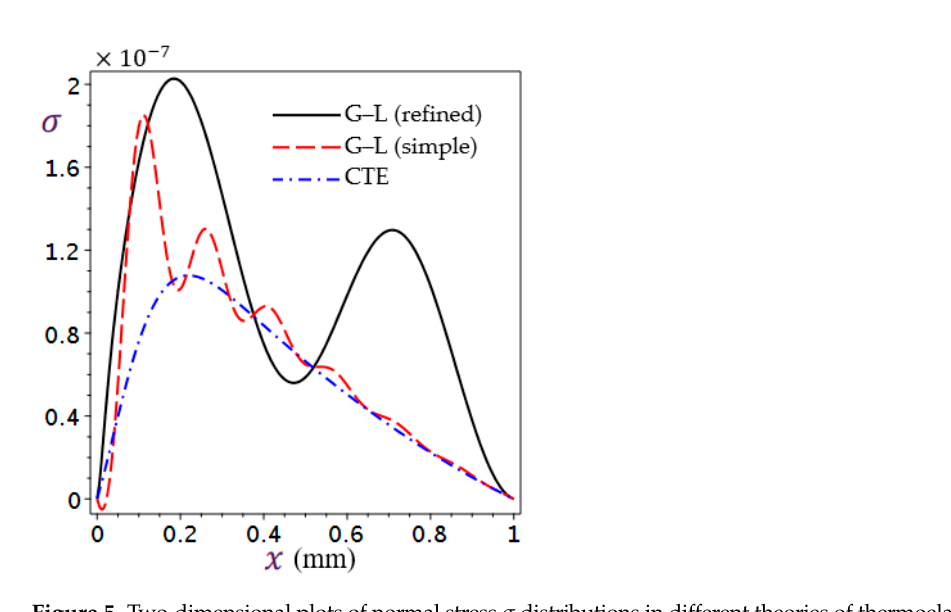
Figure 7. Effect of ramp-type heating parameter 𝑡 (cid:2868) on displacement 𝑢 .